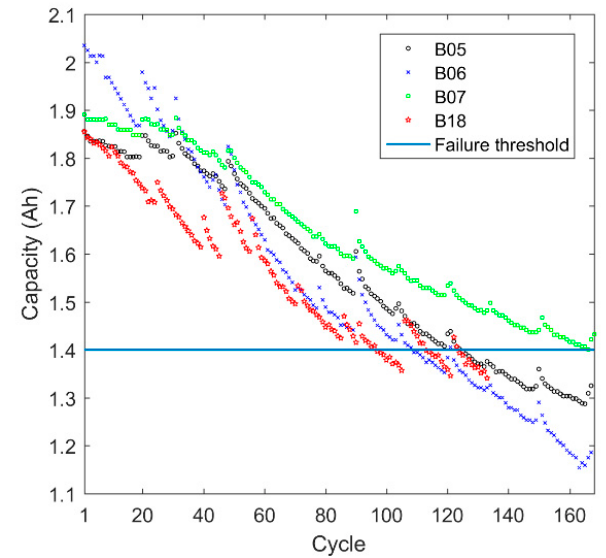
Figure 4. NASA Ames Research Center Prognostics Center of Excellence battery dataset.